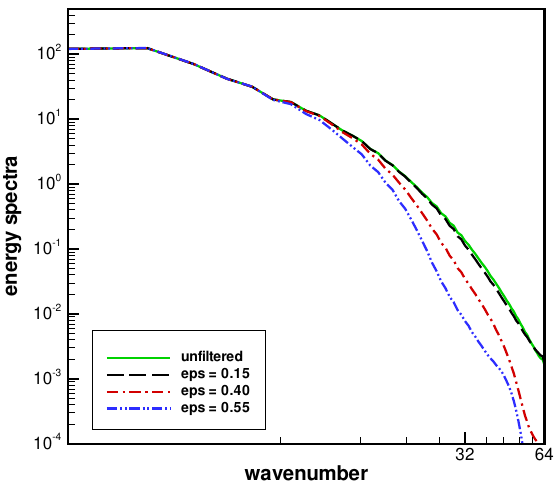
Figure 1. Energy spectra for a wavelet-filtered instantaneous velocity field with different thresholding levels along with the unfiltered